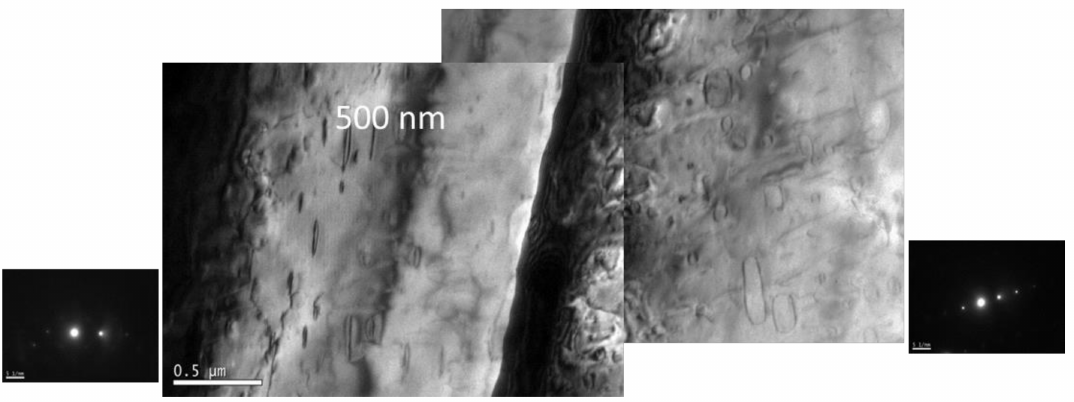
Figure 29. Irradiation sink effect at a grain